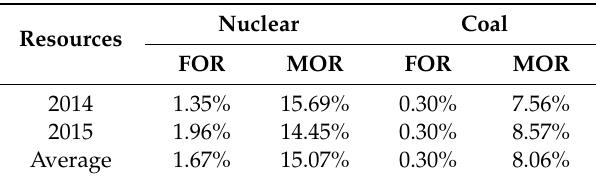
Table 2. Average forced outage rate (FOR) and maintenance outage rate (MOR) values of South Korean nuclear and coal power plants.